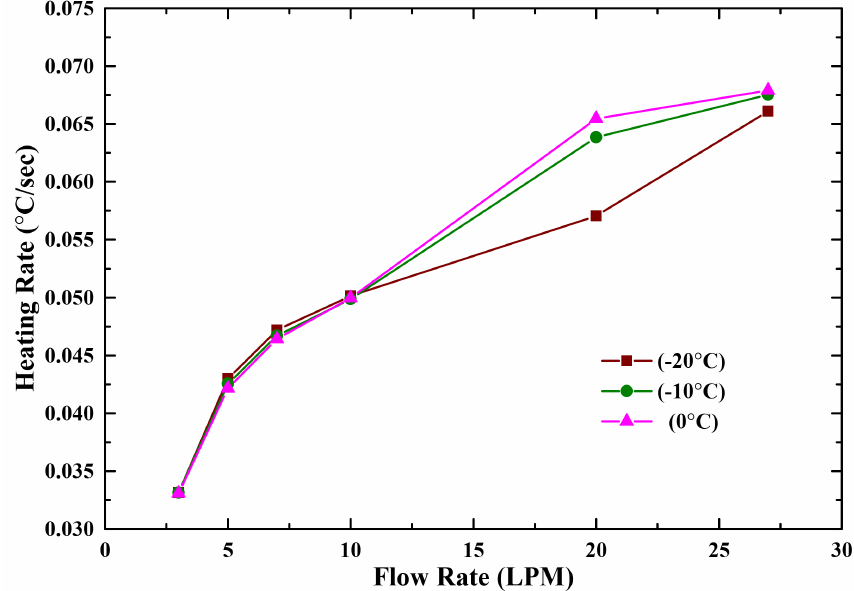
Figure 10. Heating rate as a function of flow rate with heater capacity: 6